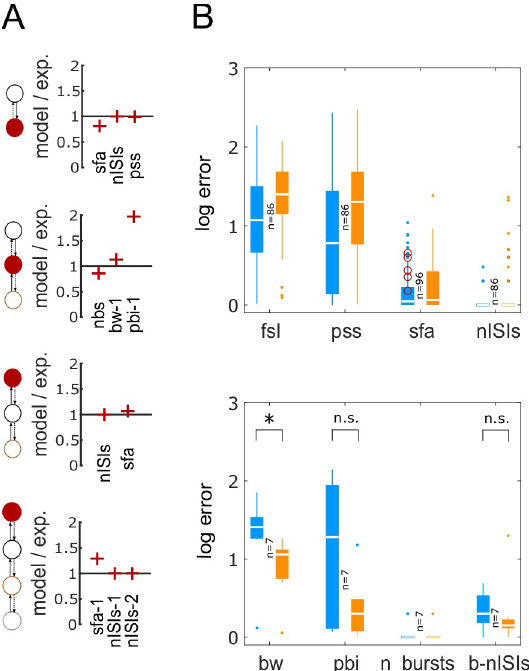
Fig 4. Accuracy of compact multi-compartment models in reproducing spike pattern features. ( A ) The goodness- of-fit is given (only) for key features for each of the four examples from Fig 3 (see S4 Table for all features). ( B ) Pairwise comparisons of accuracy between single-compartment (blue) and compact-MC (orange) models for spiking features (top) and bursting features (bottom). While single-compartment models, in general, showed smaller errors for spiking features, they did not satisfy statistical criteria for RASP.ASP. patterns (denoted by circles in top panel). See S4 Fig for an example for RASP.ASP. pattern. At the same time, compact-MC models generally improved the accuracy of bursting features (bottom) with a significant improvement in bw (p < 0.005 for paired-sample t-